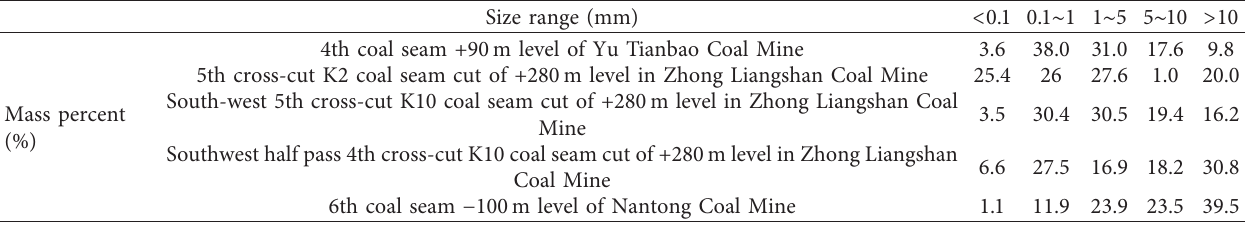
Table 3: Statistical sizes data of outburst coal particle’s out of the cavern [17].